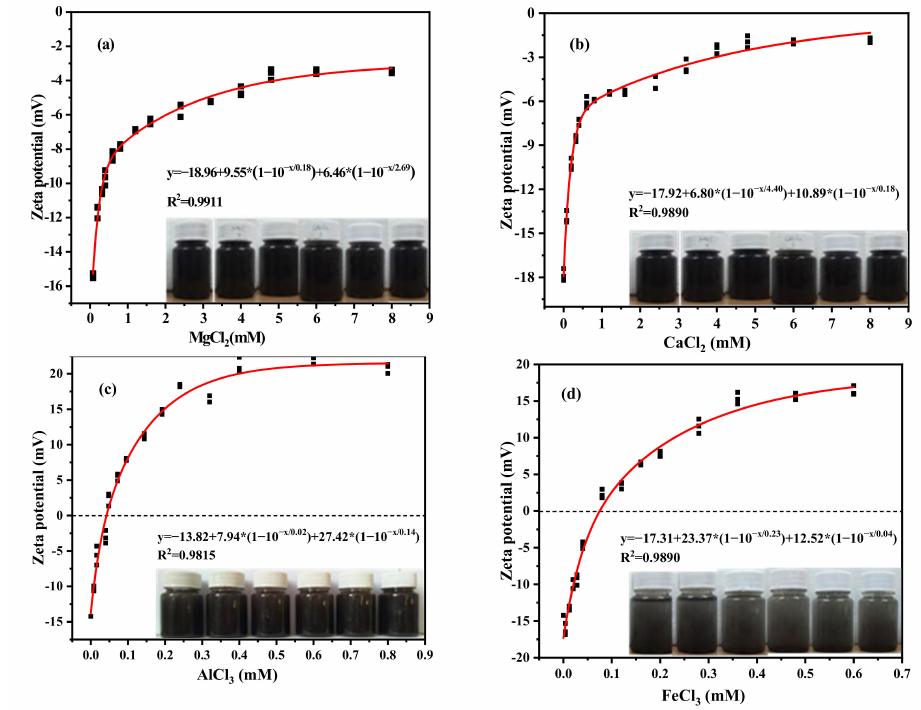
Figure 3. Zeta potential under different coagulants ( a – d